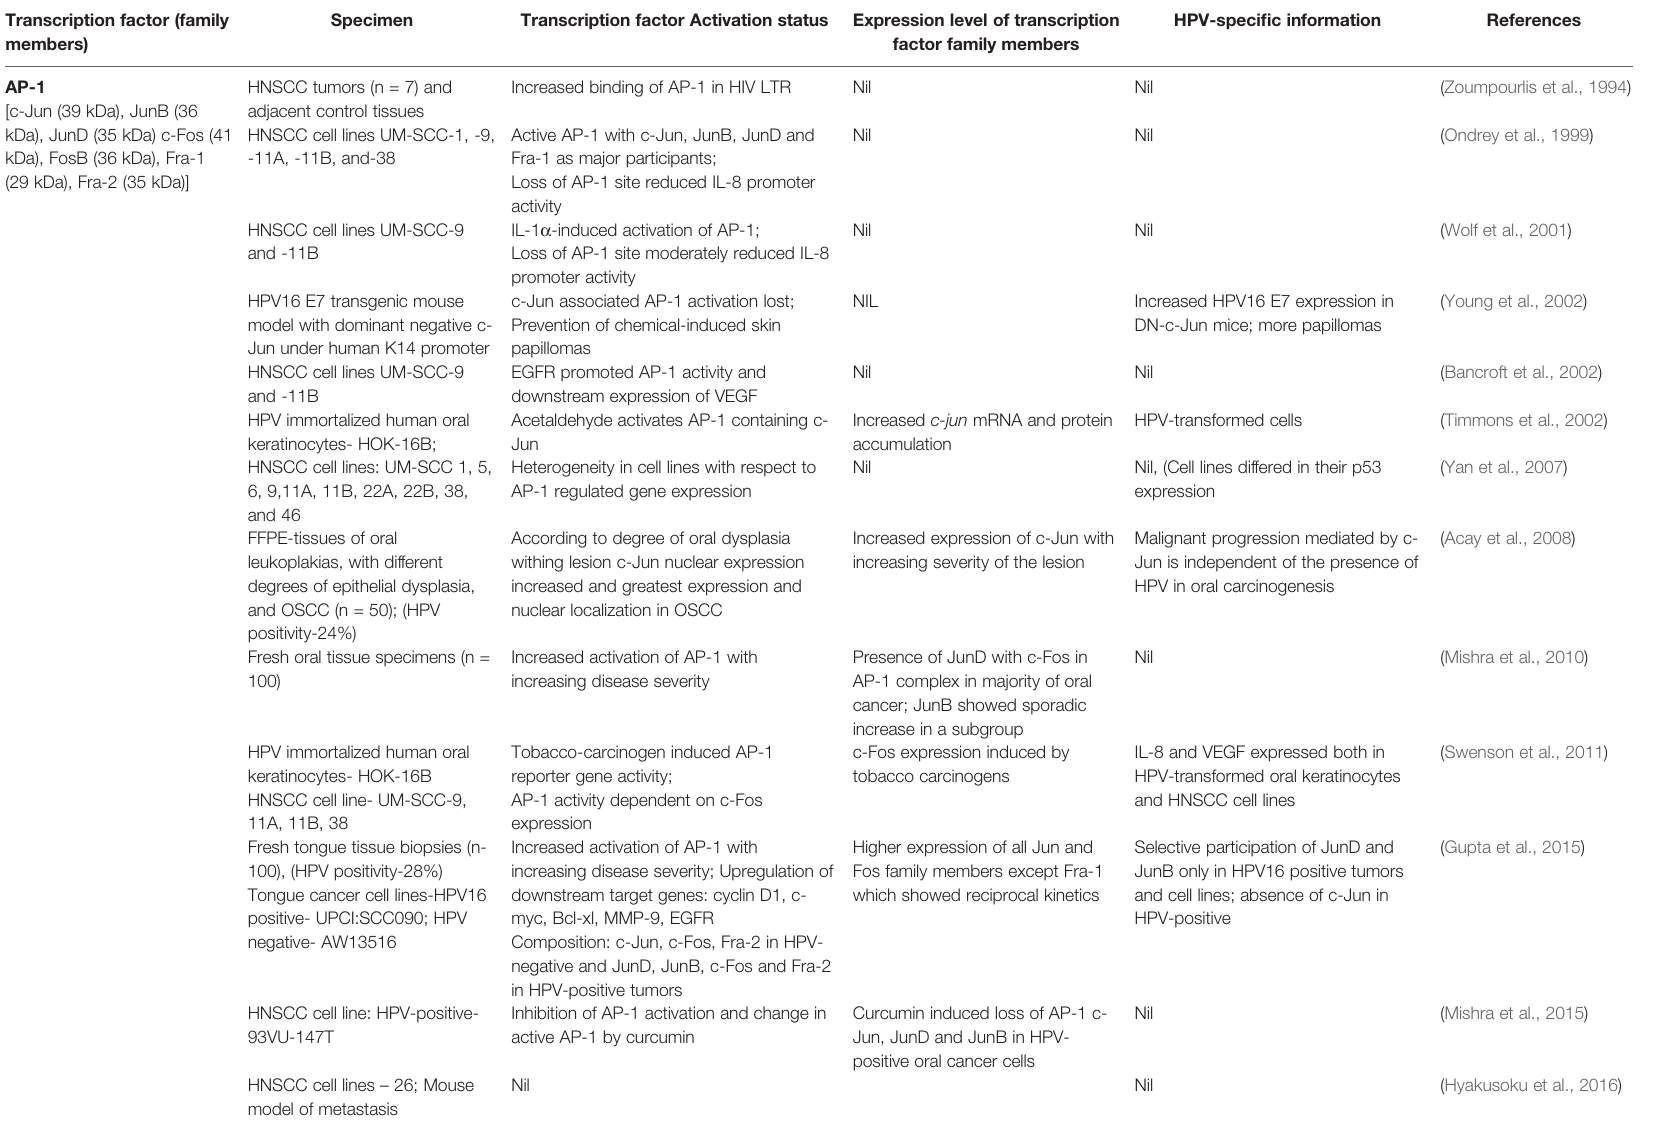
TABLE 2 | Expression and activity of key HPV-related transcription factors in normal and tumor tissues of H&N